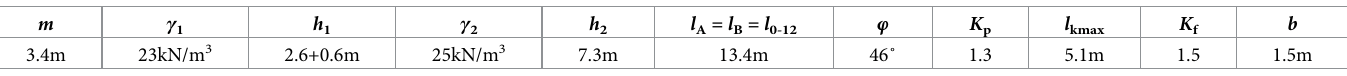
strata ( q ). The roof structure is named the voussoir beam balanced structure. And the MSSC 0 ( P ) includes the weight of the immediate roof ( Q ) and the force acting on the shield when the 0 rock blocks of the voussoir beam are generated by thick main roof slip instability ( F ). Table 7 shows the relevant parameters and information about the roof strata above No.12 -1 coal seam. According to Eq (19), a load of overburden strata on the main roof of No.12 coal seam -1 can be calculated, as shown in Table 8. From Table 8, the load of the sixth stratum (in Table 7) on the third stratum (in Table 7) is less than the load of the seventh stratum (in Table 7) on the third stratum (in Table 7), hence the load on the main roof of No.12 coal seam ( q ) is 330.40kPa. In addition, the periodical -1 0 weighting interval of the main roof of No.12 coal seam is 13.4m calculated by Eq (5). -1 Through Eqs (1), (2), (4), (21) and (30), the MSSC in No.12 coal seam is 4101.63kN based on -1 the parameters in Table 9. No.9 coal seam. Fig 12 shows the roof structure characteristic after No.9 coal seam min- ing. The interaction system between the shield and roof strata is composed of the shield, canti- lever beam of the immediate roof, and voussoir beam of the main roof. And the load on the rock blocks A and B of the voussoir beam of the main roof is a given load of loose body of the gangue ( q ) in the gob after No.8 coal seam mining. The roof structure is named the voussoir s beam balanced structure with a given load of loose body. And the MSSC ( P ) includes the weight of the immediate roof ( Q ) and the force acting on the shield when the rock blocks of 0 the voussoir beam are generated by thick main roof slip instability ( F ). Table 10 shows the relevant parameters and information about the roof strata above the No.9 coal seam. The No.9 coal seam is mined after mining the upper No.8 coal seam and lower No.12 coal -1 seam. Because of the mining influence on the roof and floor strata, the primary cracks in the roof and floor strata are relatively developed without damage to the overall structure. Table 9. Calculation parameters of MSSC in No.12 -1 coal